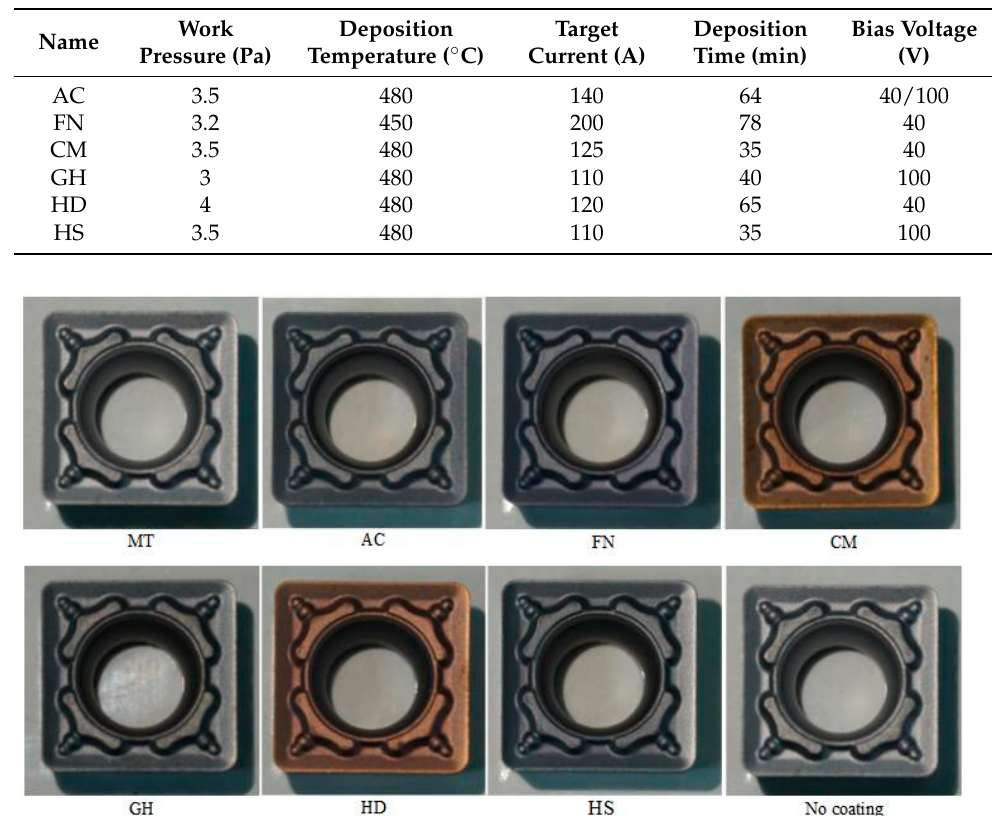
Figure 1. Cutting tool inserts with different